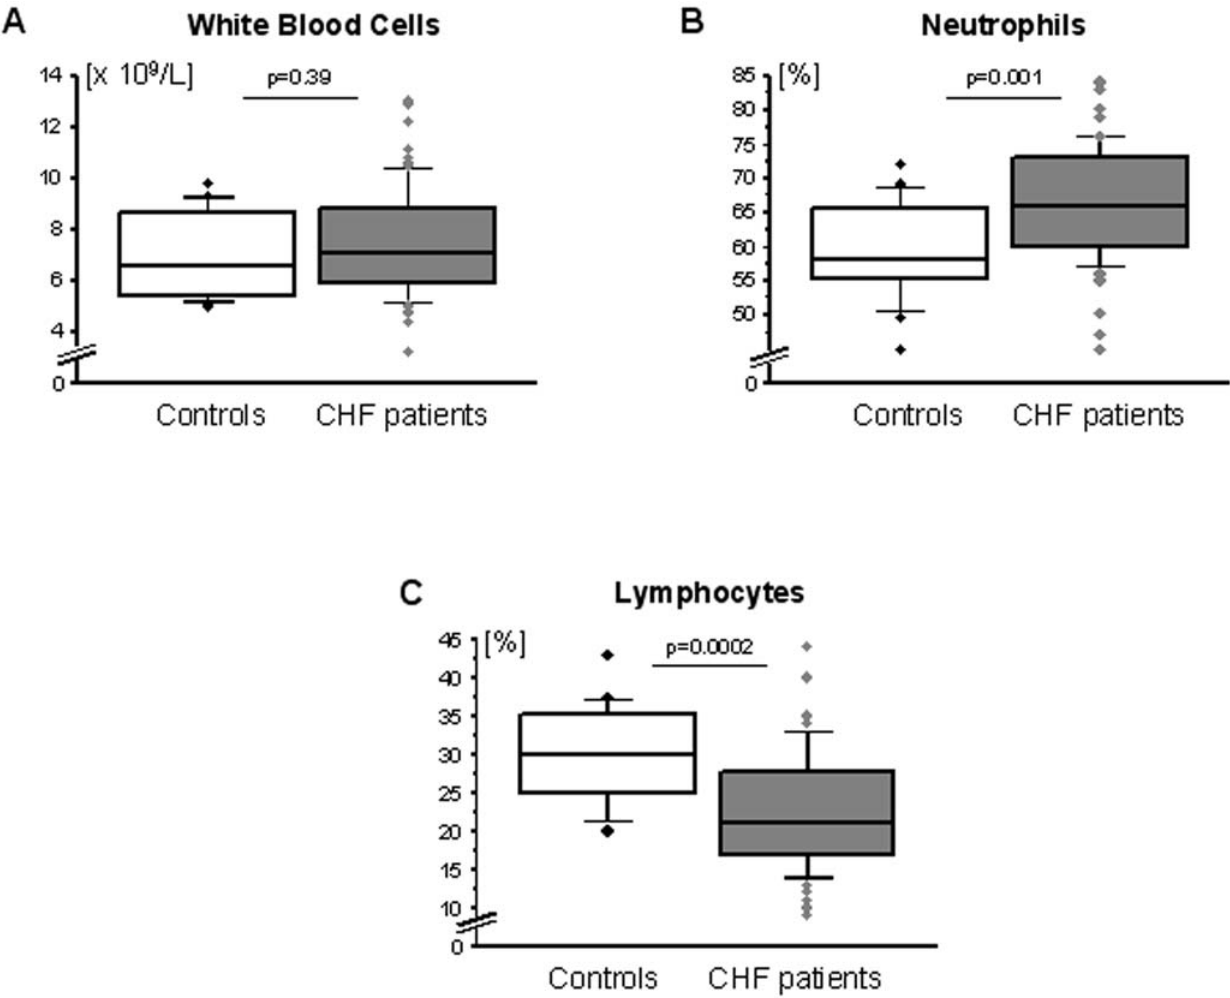
Figure 2. Distribution of leukocytes (panel A) and their subsets (panels B and C) in healthy control subjects (n=20) and patients with CHF (n=75).